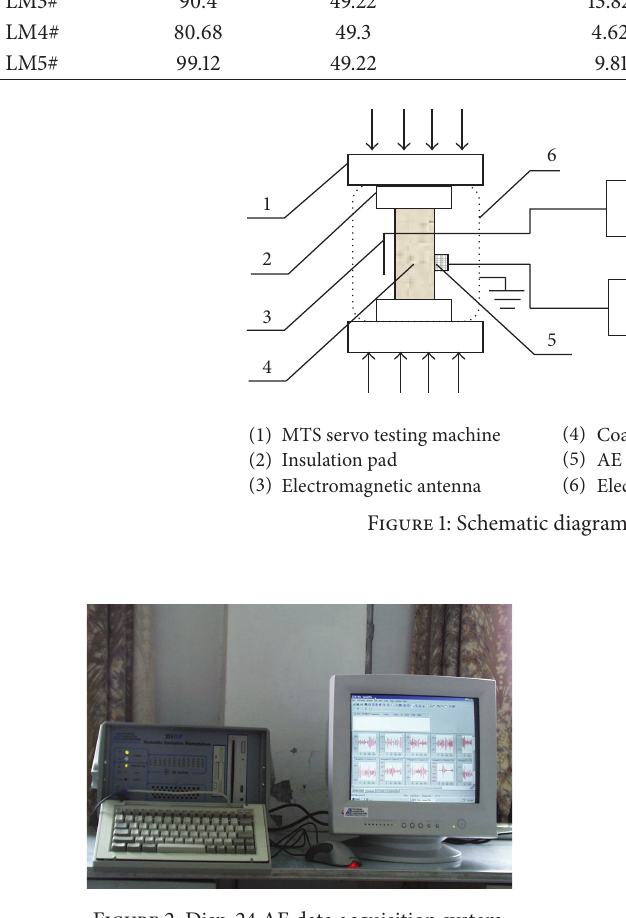
Figure 2: Disp-24 AE data acquisition system.